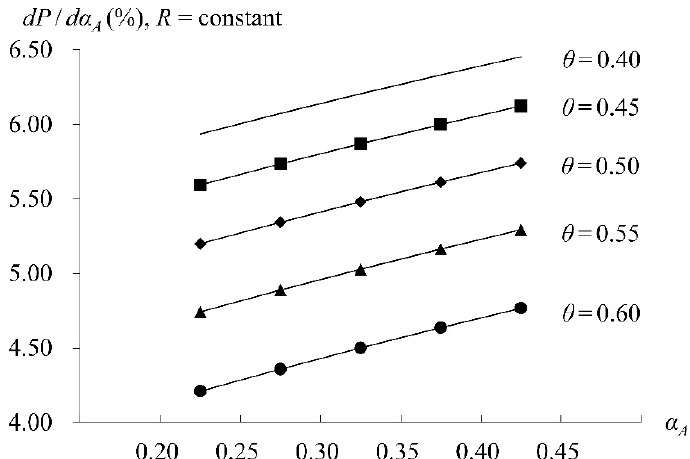
Figure 2. Responsiveness of default risk to overconfidence degree at various levels of buying distressed assets by the government based on Equation (14). Parameter values, unless stated otherwise, δ = 0.65, σ = 0.30, m = 0.10%, α = 0.95, R M = 5.00%, R B = 4.00%, β = 0.60, M = 60, and R = 2.25%. All results are valued at the optimal R A of 5.60%. The negative indirect effect, ( ∂ P / ∂ R A )( ∂ R A / ∂α A ) < 0, is insufficient to offset the positive direct effect, ∂ P / ∂α A >